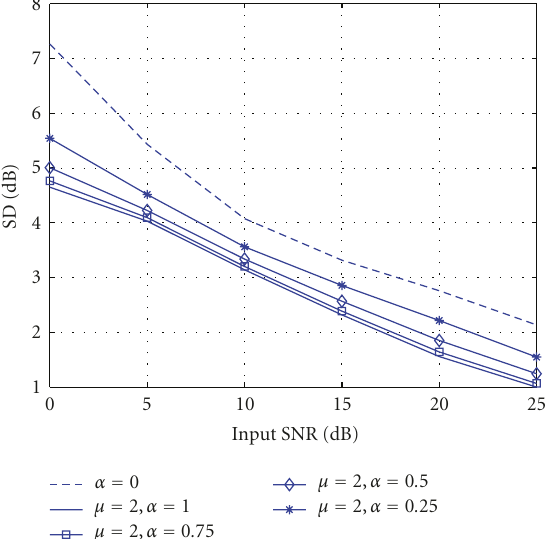
Figure 15: Signal distortion for SDW-MWF SPP ( α = 0) and SDW-MWF μ ( α = 1) with μ = 2 at di ff erent input